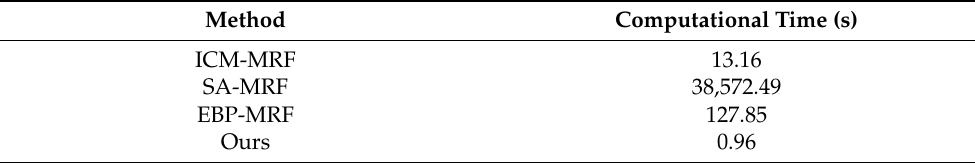
Table 11. Comparison of the computational cost on test data